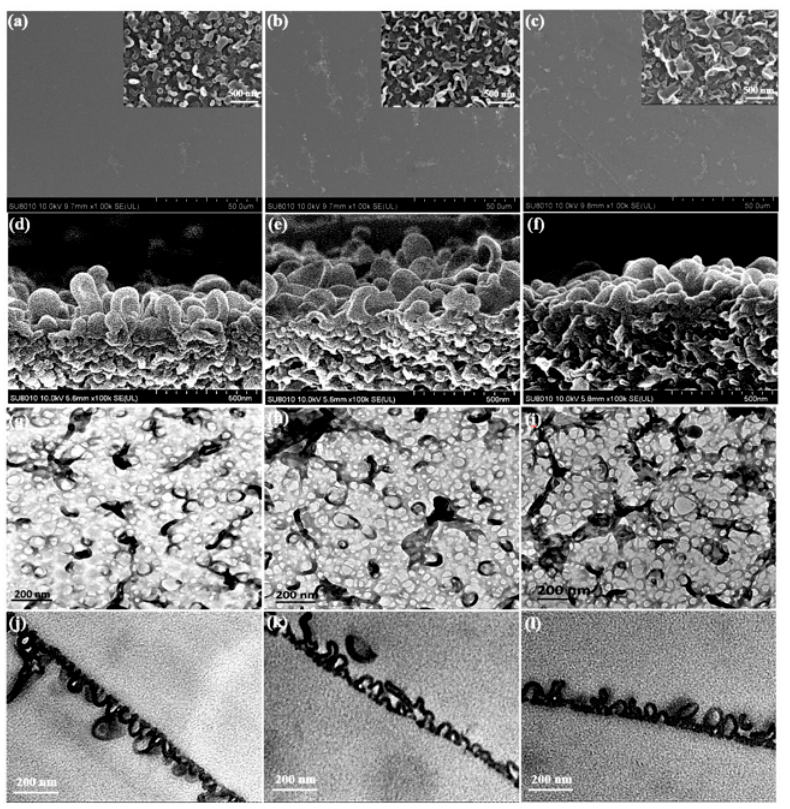
Figure 5. SEM and TEM micrographs of the top surface and cross-section for TFC and TFN mem- branes with different ODA@GO nanosheet loadings: ( a , d , g , j ) TFC (0%, w / v ), ( b , e , h , k ) TFN － 2 (0.003%, w / v ) and ( c , f , i , l ) TFN － 5 (0.02%, w / v ).